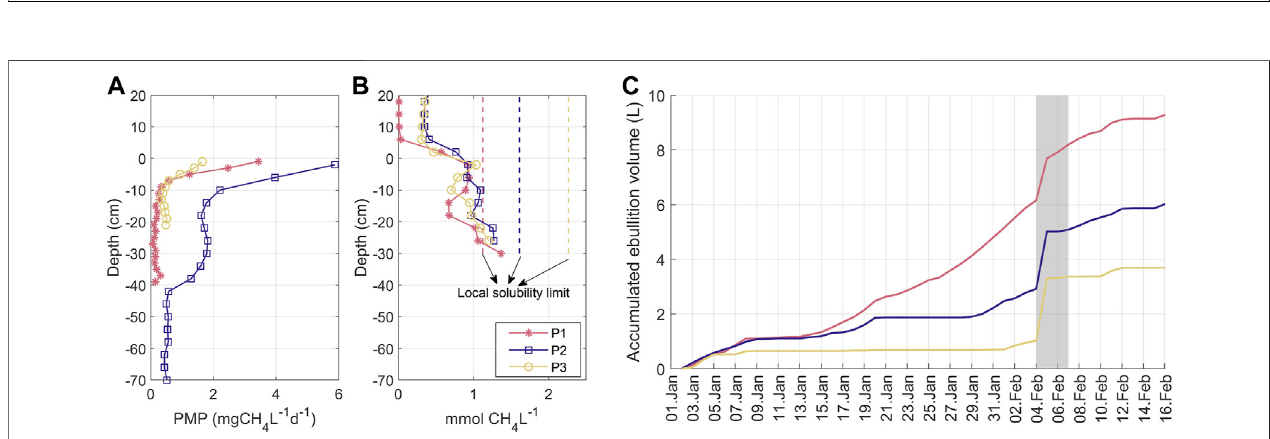
FIGURE 3 | (A) Depth pro fi les of potential methane production (PMP) in the sediment [data from Hilgert et al. (2019b)] (B) dissolved methane concentration in the porewaterandoverlayingwateratthesediment-waterinterfacemeasuredin2019.Theoriginofthedepth-axisisatthewater-sedimentinterface.Thedashedlinesshow the respective CH 4 solubility limit for each location, calculated as a function of temperature, salinity, and hydrostatic pressure according to Dale et al. (2008). (C) Time series of accumulated gas volume recorded by the automated bubble traps (ABTs) from 1 January to 15 February 2019. The grey shaded area marks the days whentheecho-soundingsurveywasconductedin2019.AllthreepanelsshowmeasurementsatthethreesamplinglocationsinPassaúnaReservoir(P1,P2andP3,see Figure 1 ).